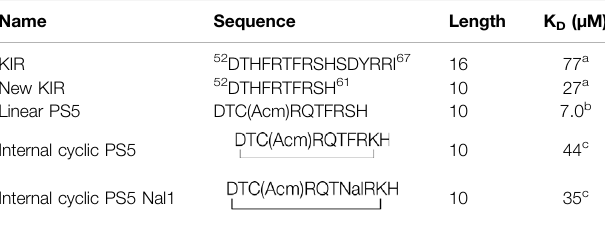
TABLE 2 | SOCS1 proteomimetics: name, sequence, length, and dissociation constants values (µM) toward JAK2 catalytic